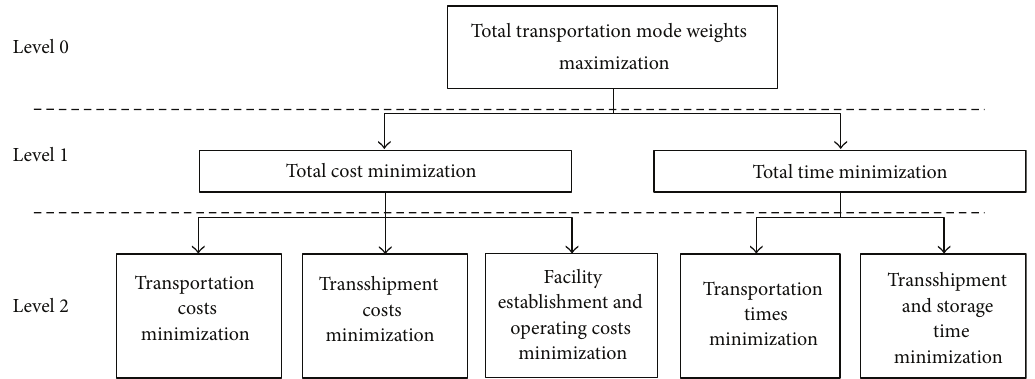
Figure 3: Hierarchy of the